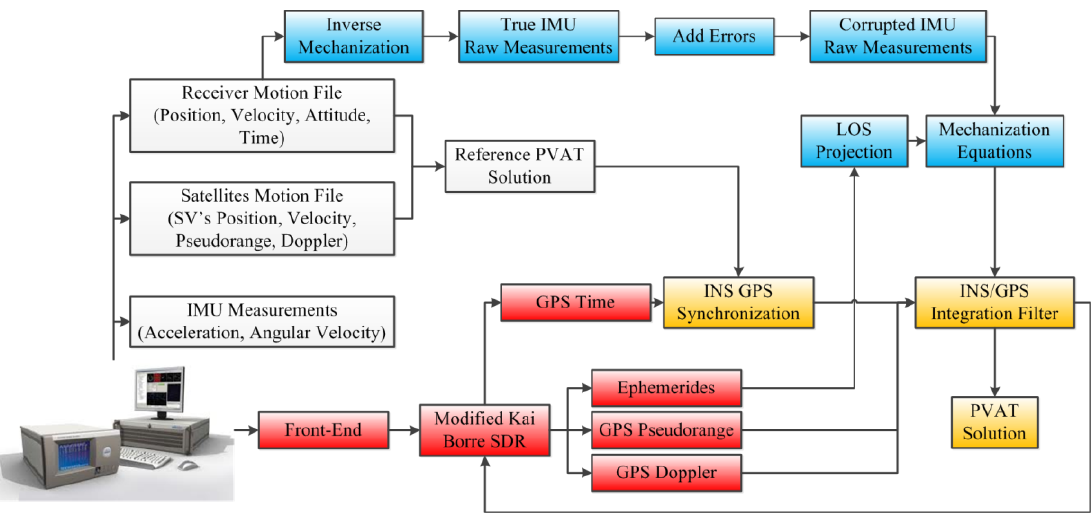
Figure 6. TCAPLL simulation testing platform.